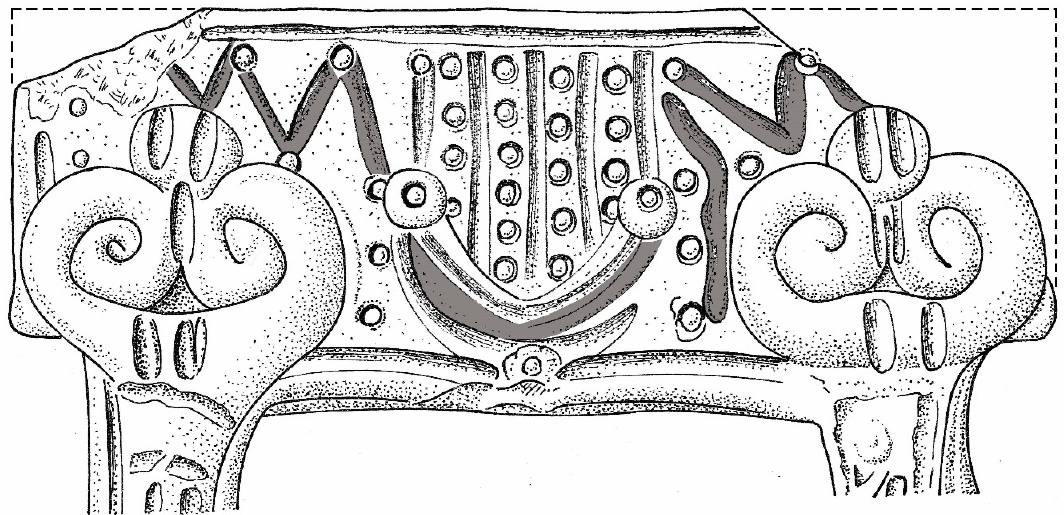
Figure 13. Drawing of the upper part of the portable shrine from Tell el-Far‘ah North, emphasizing the folded curtain.